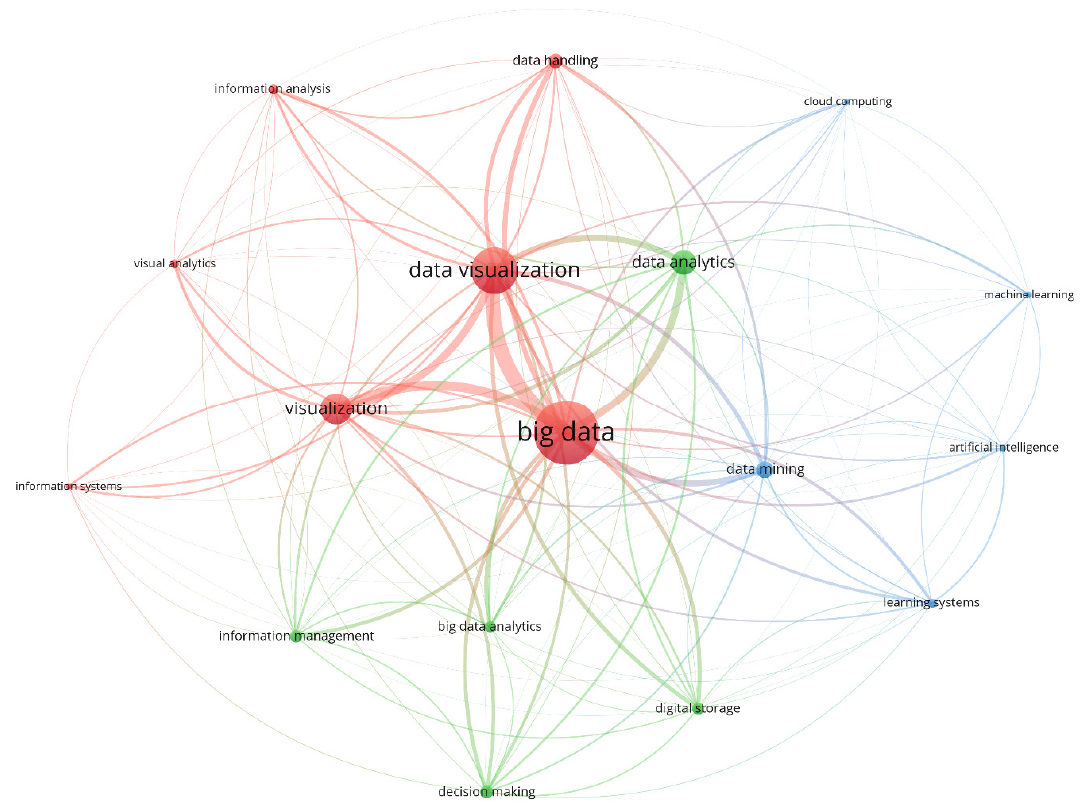
Figure 2. Most frequent keywords in the big data articles from 2010 to 2020.